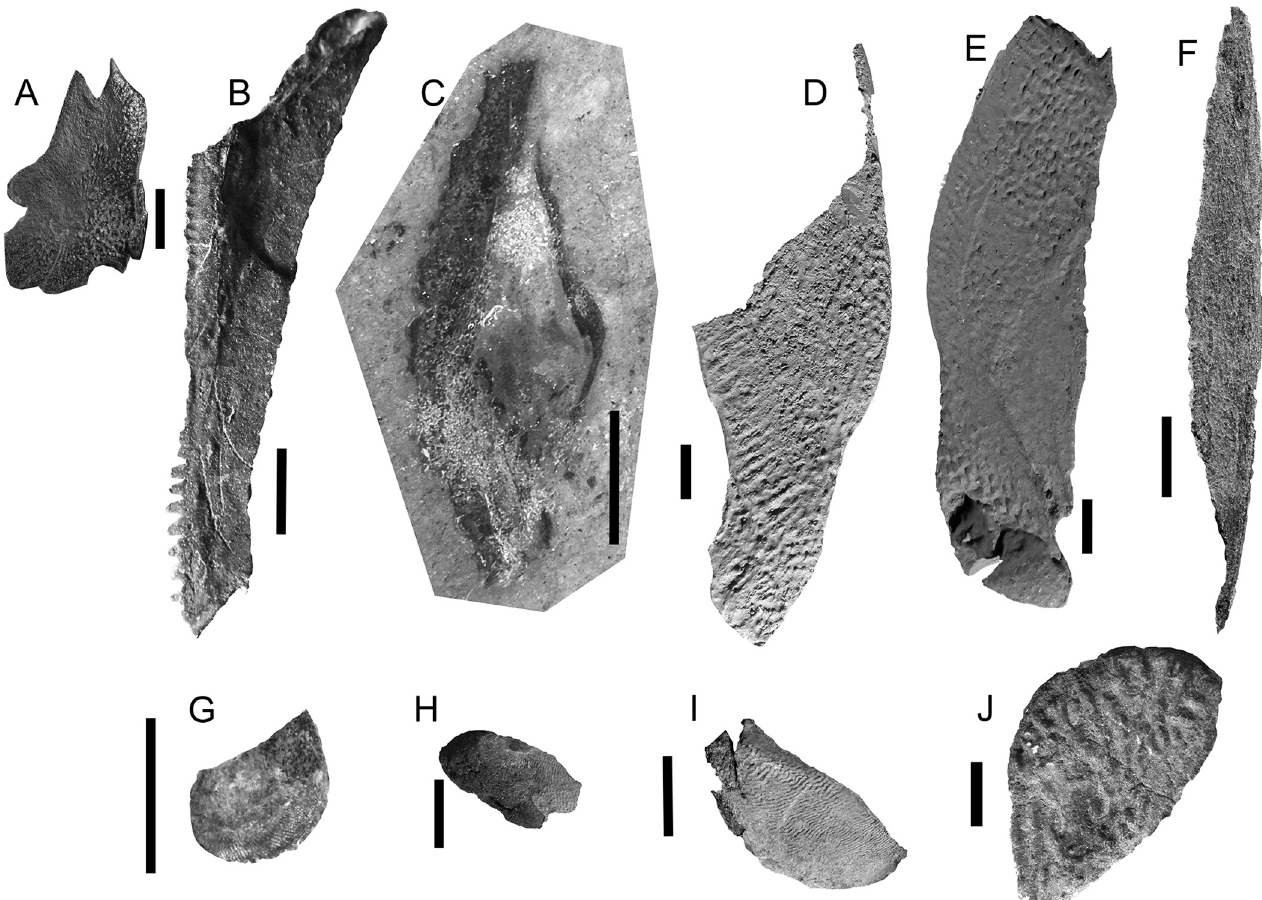
Fig 9. Bothriolepis dairbhrensis sp. nov. Elements of the proximal segment of the pectoral fin elements. A. Mesial marginal plate 1, NMING:F35230. B. Mesial marginal plate 2, NHMP 59683. C. Mesial marginal plate 2, NMING:F35223. D-E. Mesial lateral plate 2, NMING:F35224 (D in lateral view, E in mesial view). F. Mesial lateral plate 2, NMING:F35225. G. Central dorsal plate 2, TCD19618 FB7052. H. Central dorsal plate 2, NHRMP 69862. I. Central dorsal plate 2, NHRMP 59680. J. Central dorsal plate 2, NHMP 59688 Scale bars 10